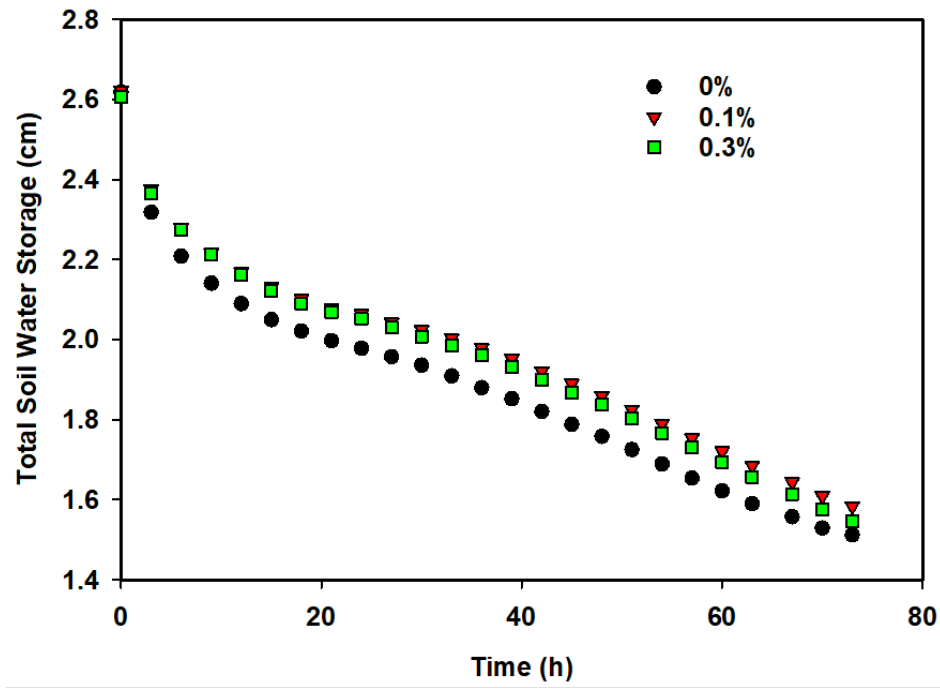
Figure 8. Change in total soil water storage in the 0, 0.1, and 0.3% ( w / w ) lignin-based hydrogel treatments after 73 h of evaporation.